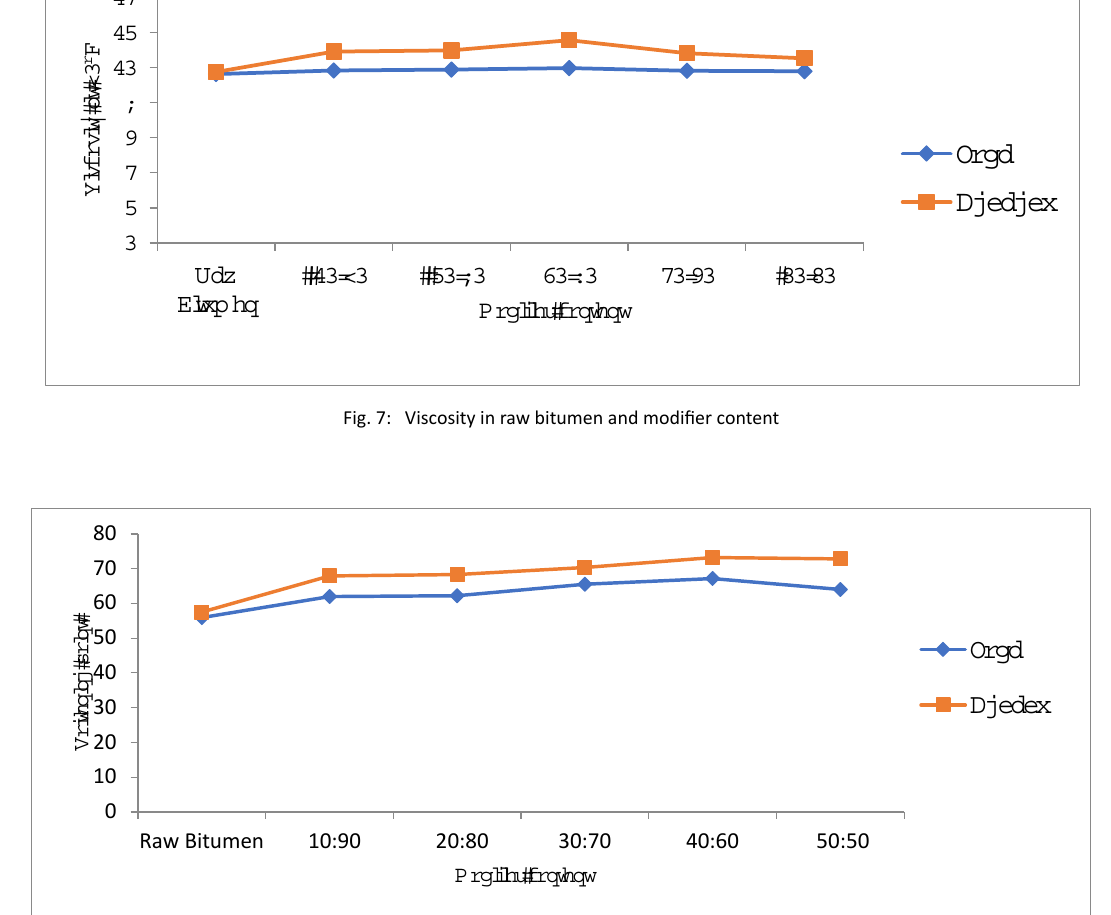
Fig. 8: Softening point in raw bitumen and modifier content